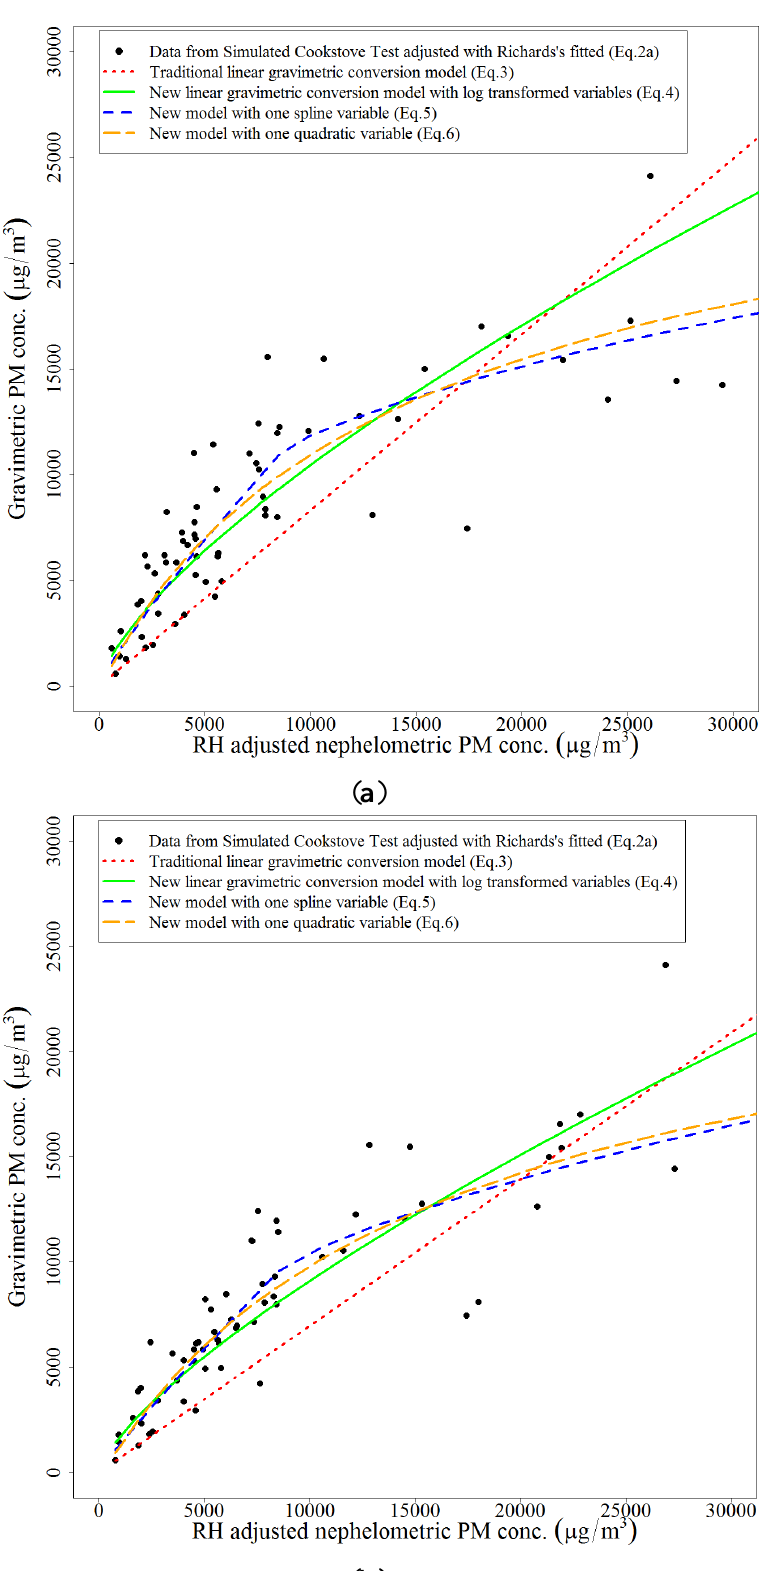
Figure 3. Linear, linear with log transformed variables, linear with spline variable, and linear with quadratic variable Equations for gravimetric conversion based on nephelometric PM concentrations adjusted with RH adjustment Equation (2 a ). ( a ) RH adjustment with 60% threshold; ( b ) RH adjustment without 60%